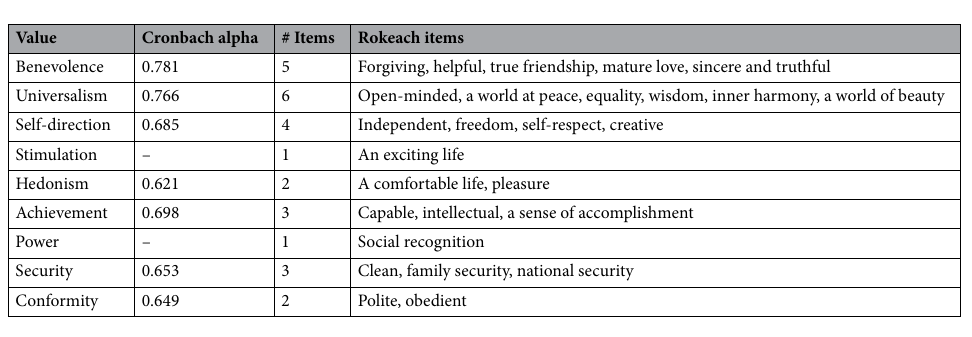
Table 6. Values, scale reliability and scale